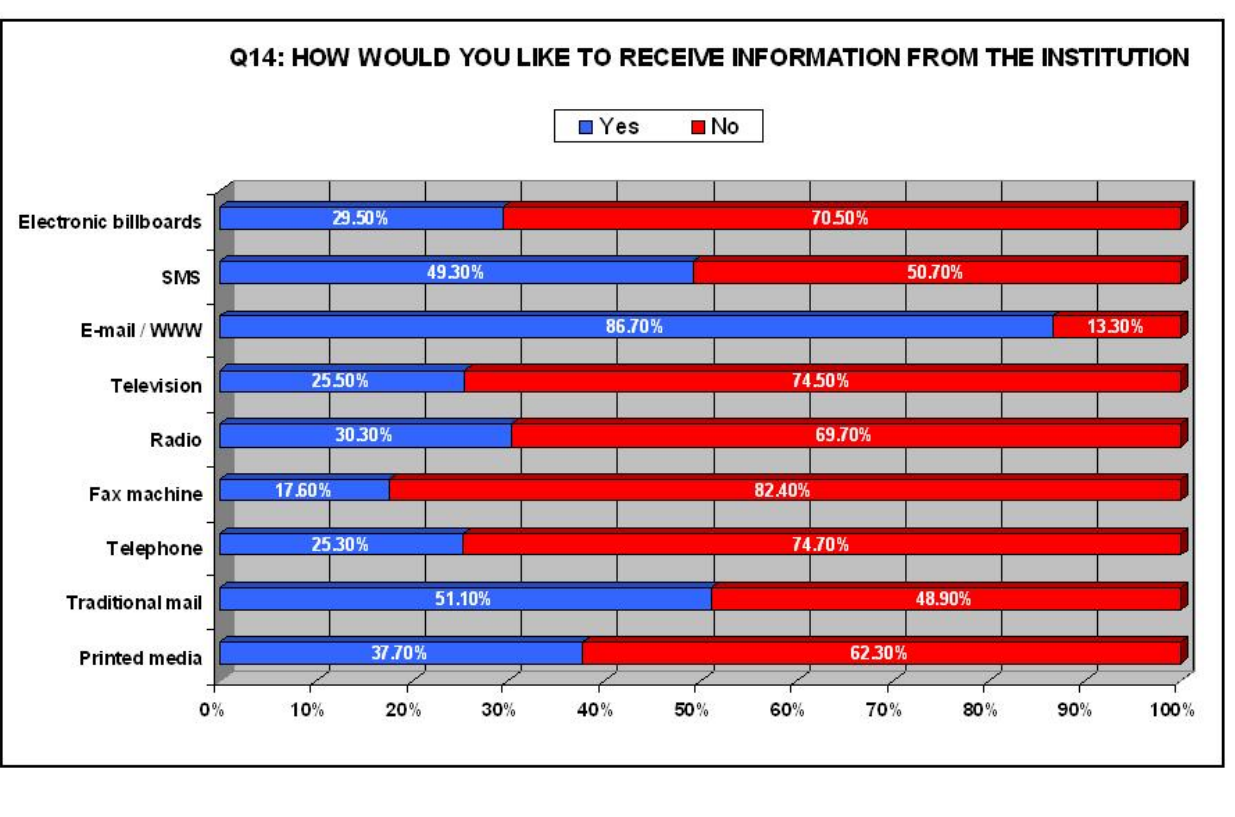
Figure 12 Representation of the responses to Question 16 of the